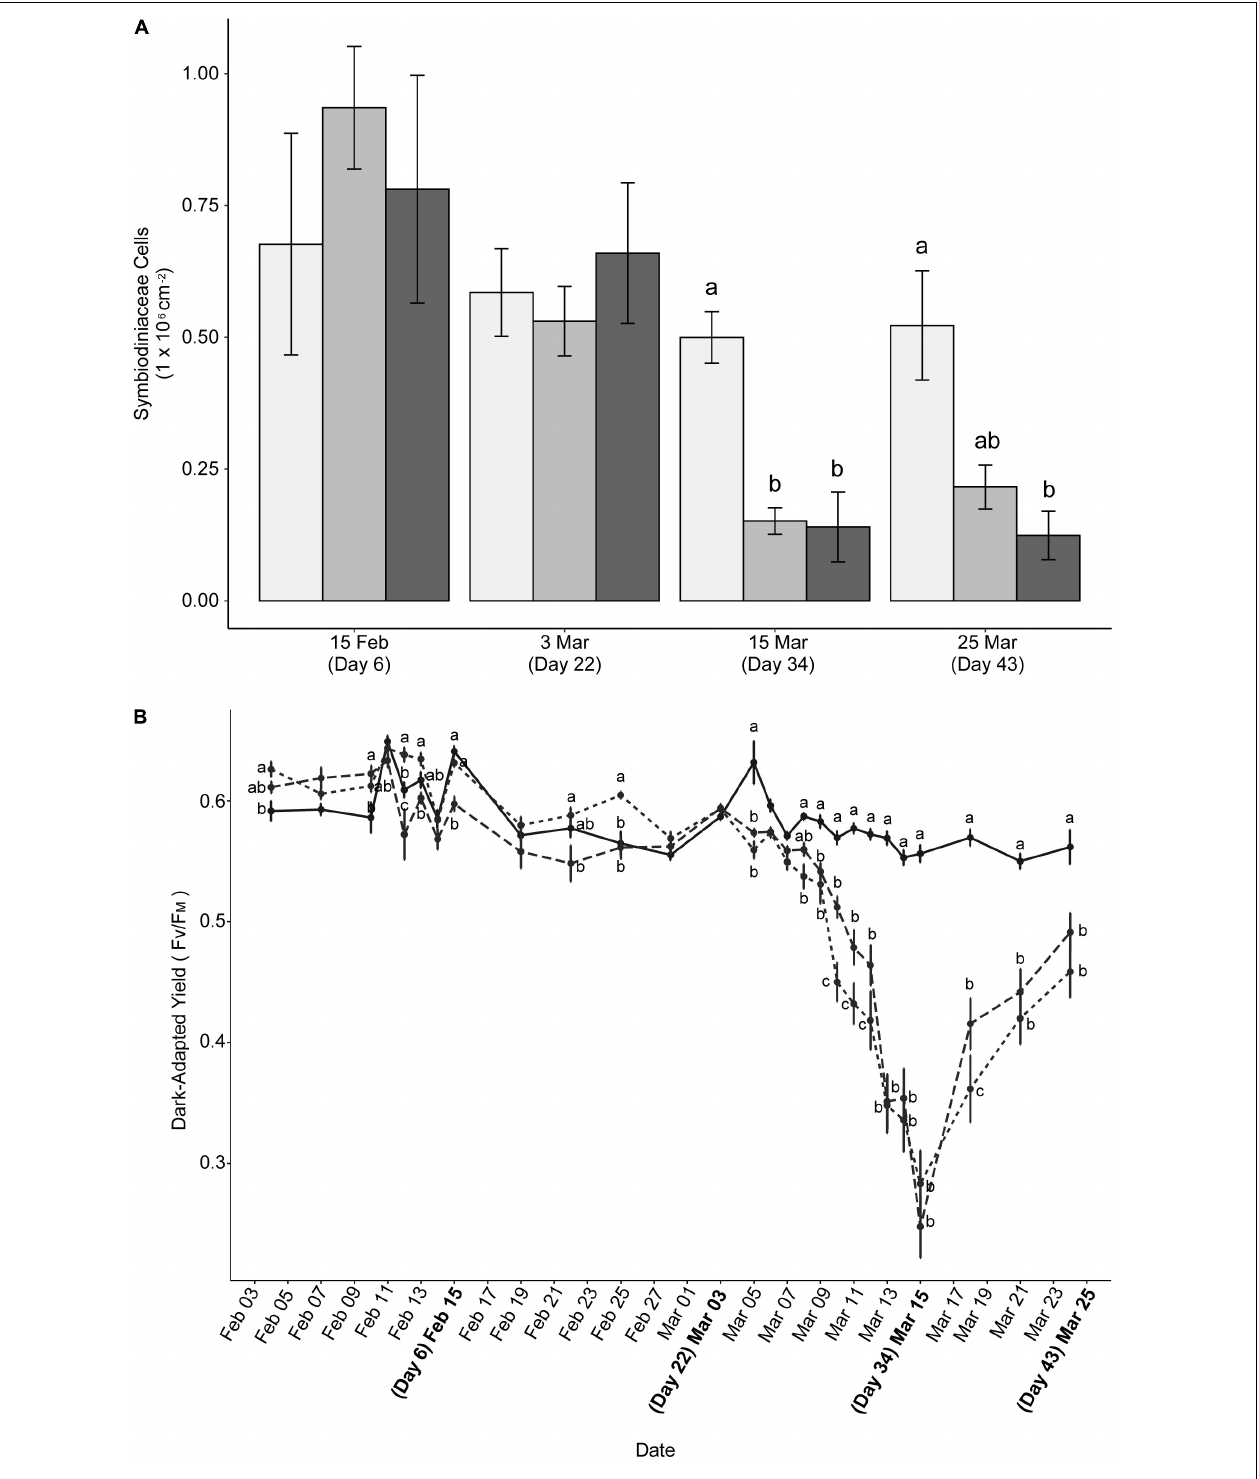
FIGURE 2 | (A) Symbiodiniaceae cell densities in response to warming trajectories. Cell densities are displayed for ambient (light gray), short stress (medium gray), and long stress (dark gray) scenarios. Data are mean ± SE ( n = 6). (B) Dark-adapted yield of colonies in ambient (solid line), short stress (short dashes), and long stress (long dashes) scenarios. Bolded dates represent sample timepoints. For both (A,B) , different lowercase letters indicate significant differences between groups on the same day (Tukey post hoc test, p < 0.05). Timepoints without letters indicate no significant differences between treatments on that day.